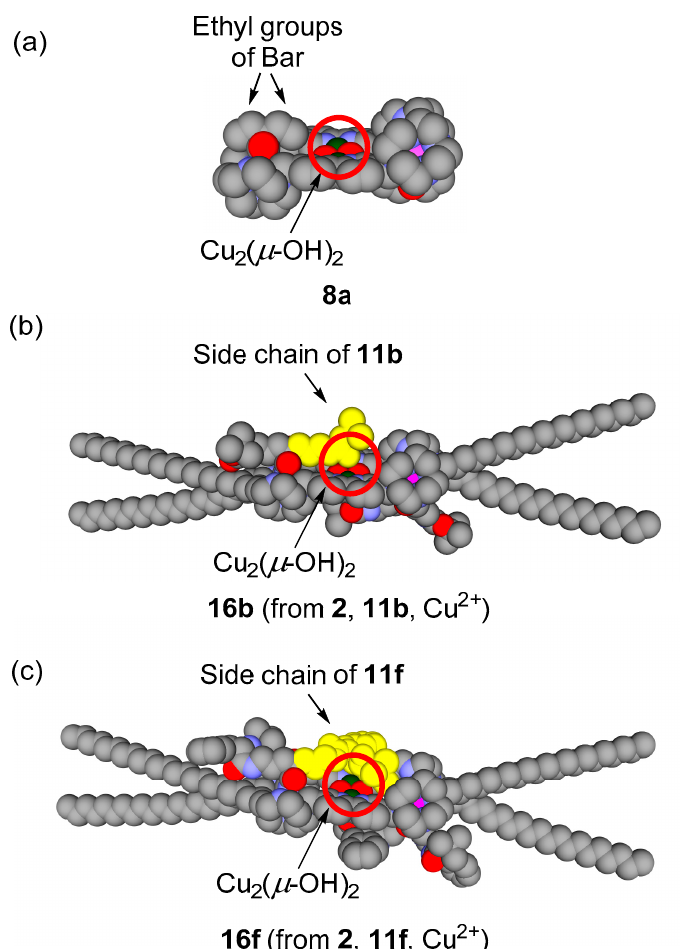
Figure 11. ( a ) X-ray crystal structure of 8a and ( b and c ) proposed structures of 16b and 16f (yellow spheres indicate the side chains of the Bar units 11b and 11f ).